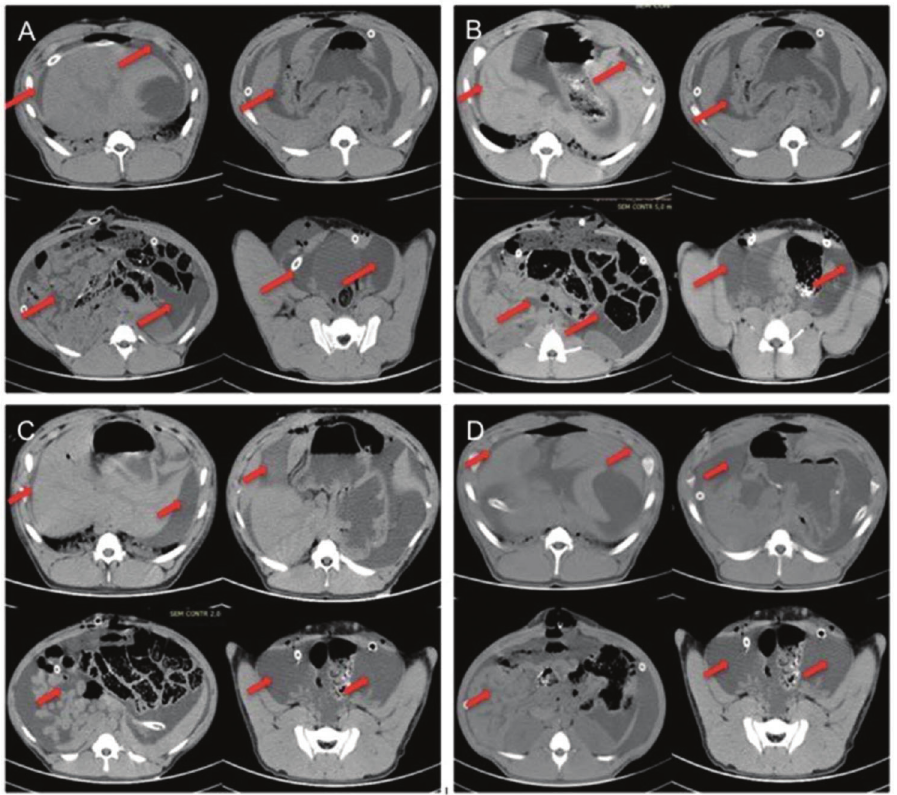
Figure 1 - (A) Pig 1, (B) Pig 2, (C) Pig 3 and (D) Pig 4. The red arrows indicate the presence of liquid in all spaces